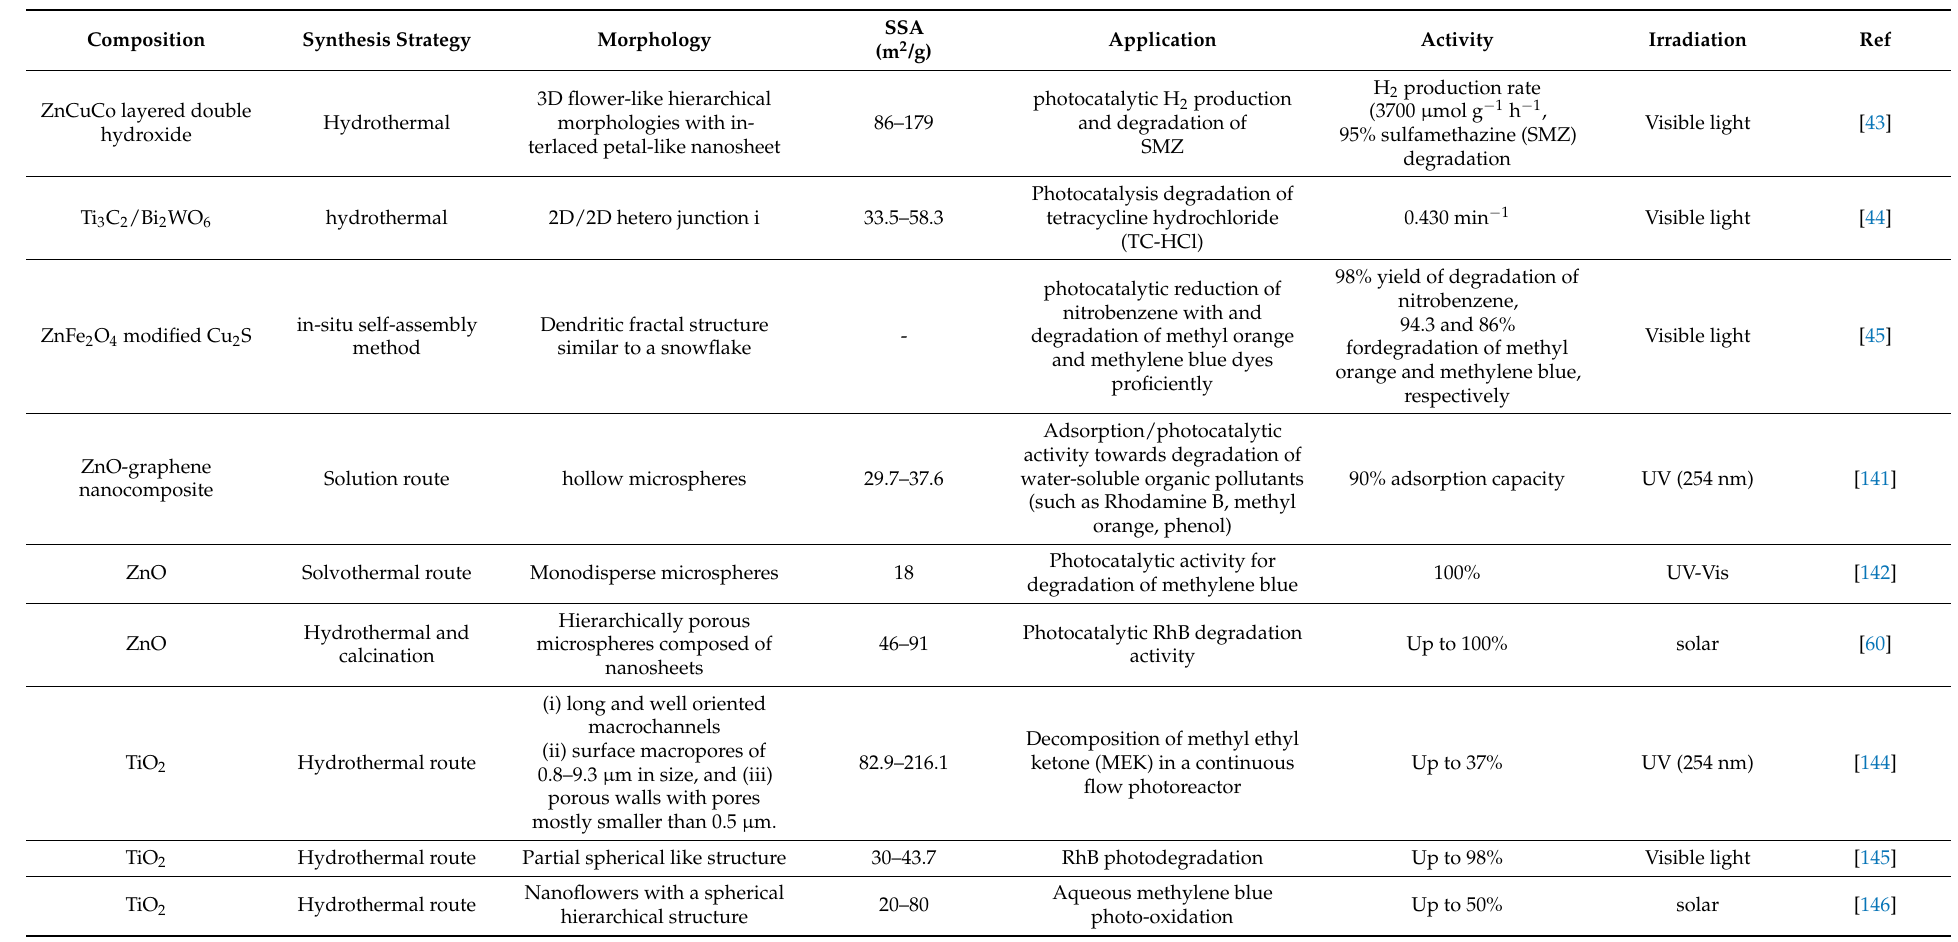
Table 5. Hierarchical catalysts produced without